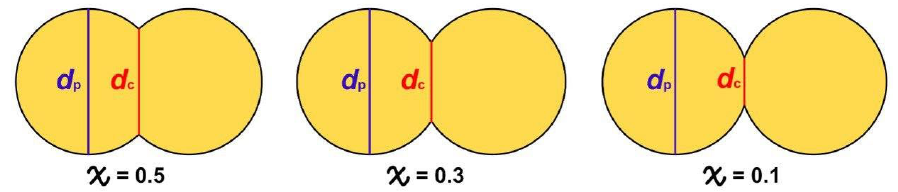
Figure 2. Image of particles with different values of relative bond strength.